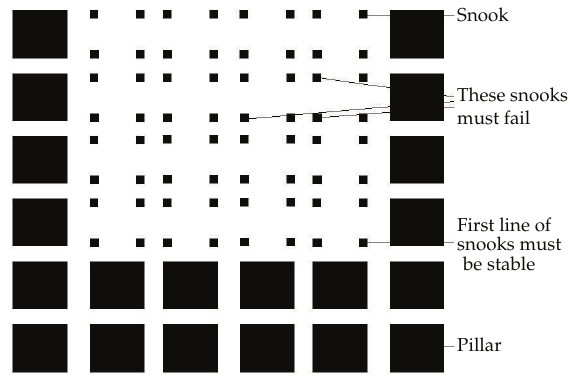
Figure 2: A mining panel showing the snooks after pillar extraction. The pillar is replaced by four snooks, one at each corner. Reproduced with permission from N. van der Merwe.